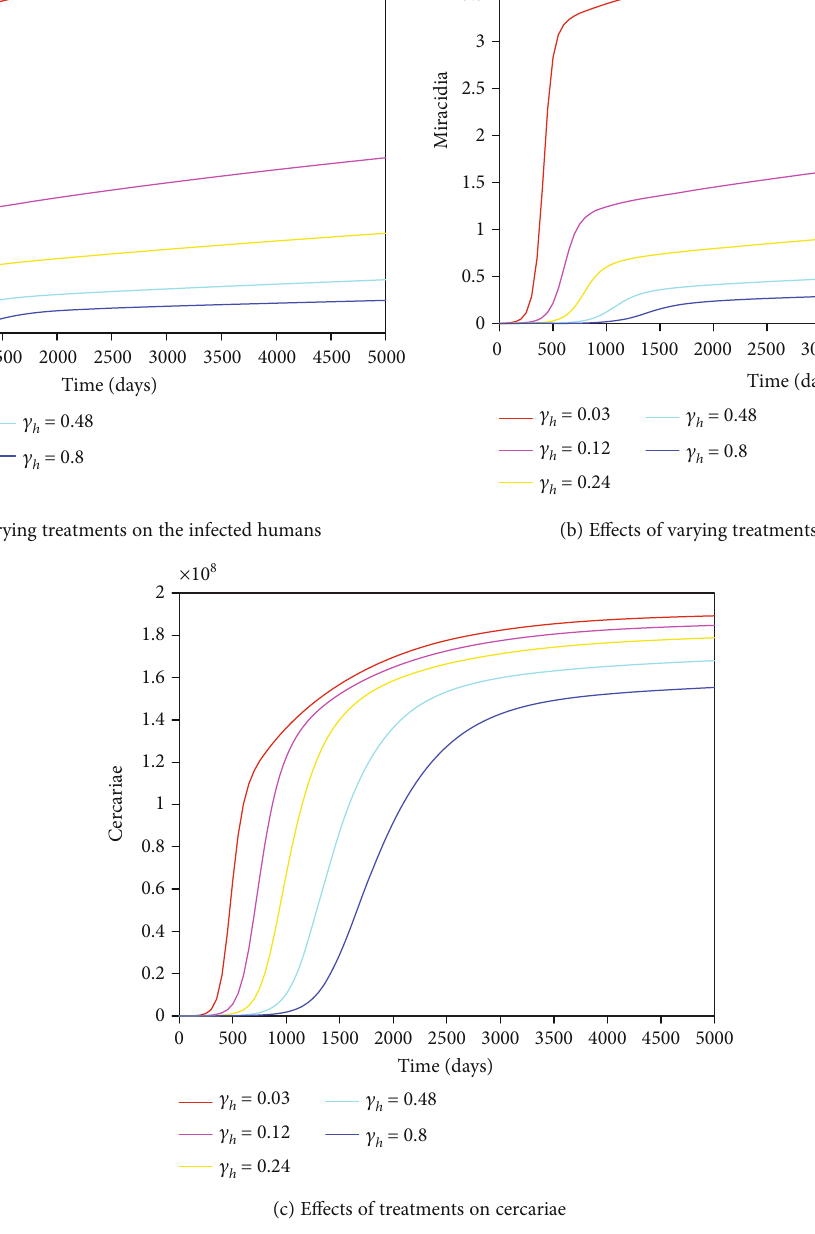
Figure 5: E ff ects of varying treatments on infected humans, miracidia, and